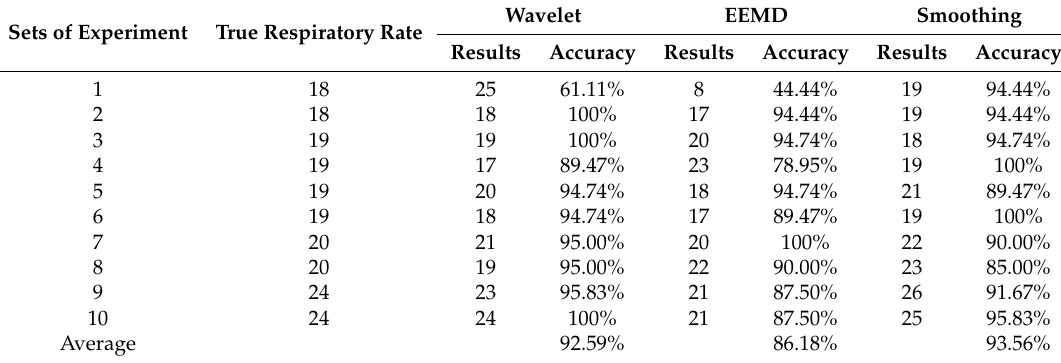
Table 3. The results of the respiratory rate test with the time period of 10